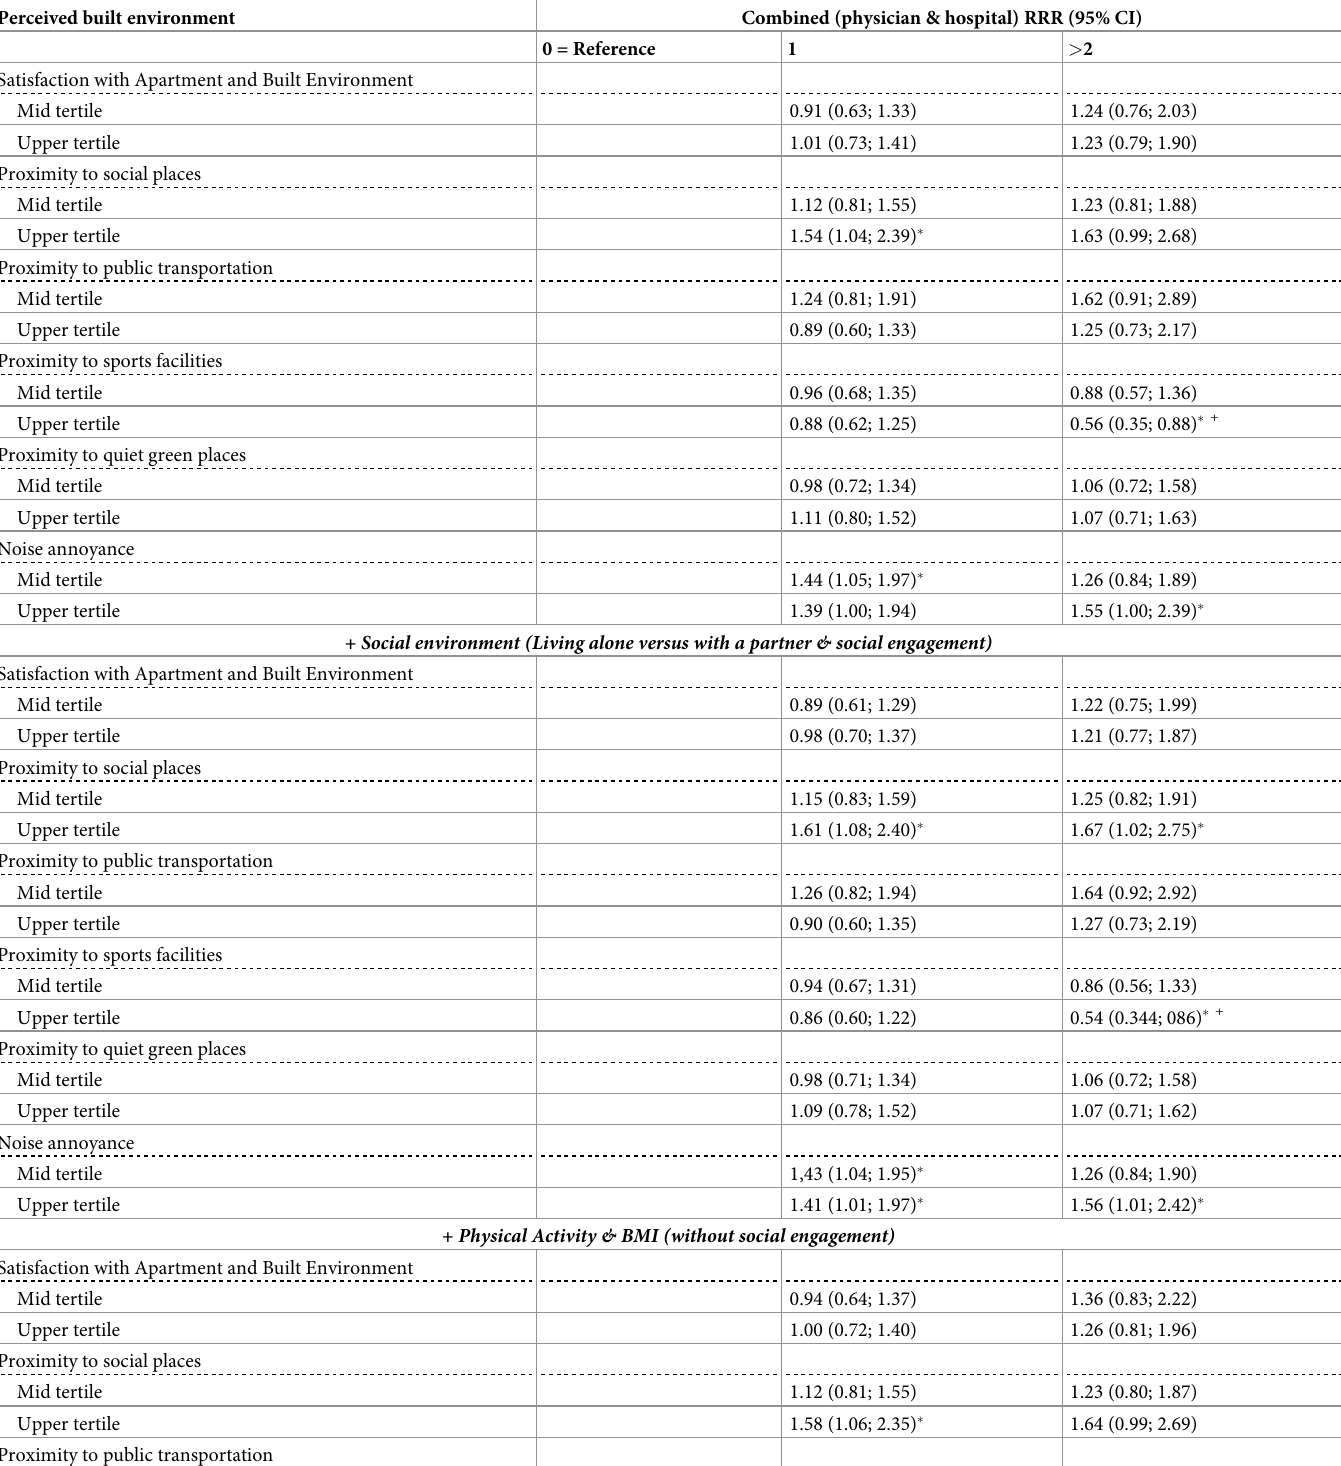
Table 3. Associations of variables defining the perceived built environment with health care utilization, with and without adjustment for the social environment, physical activity and